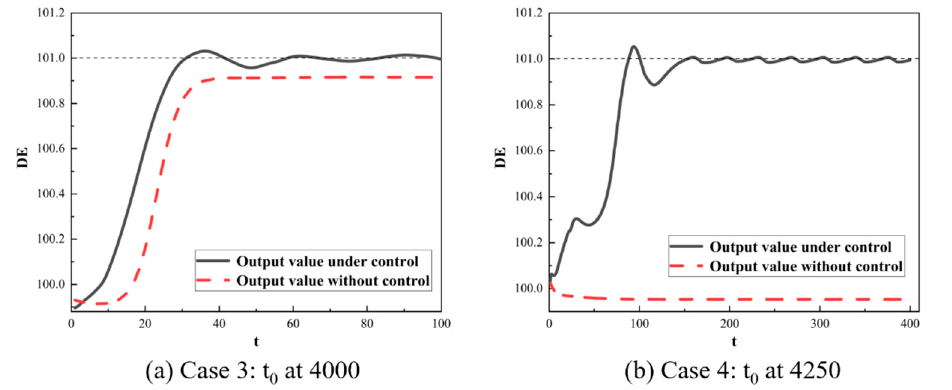
16 of 20 Figure 10. The state pro fi les of di ff erent neural network models. In reality, the prediction model of the MPC could not fully predict the actual situation in the simulation process. However, we used the same model for control and simulation in both case 1 and case 2. In order to simulate this discrepancy, we used di ff erent RNN- LSTM models for the control model and simulation model. For the simulation model, we changed the hyperparameters of the RNN-LSTM model by including fewer units in the hidden layer and retrained a new RNN-LSTM model. For the control model, we used the data in the previous 2500 periods just before the initial regulation time 𝑡 (cid:2868) , instead of the entire dataset. To simulate the accidental error in the real situation, we added a normal